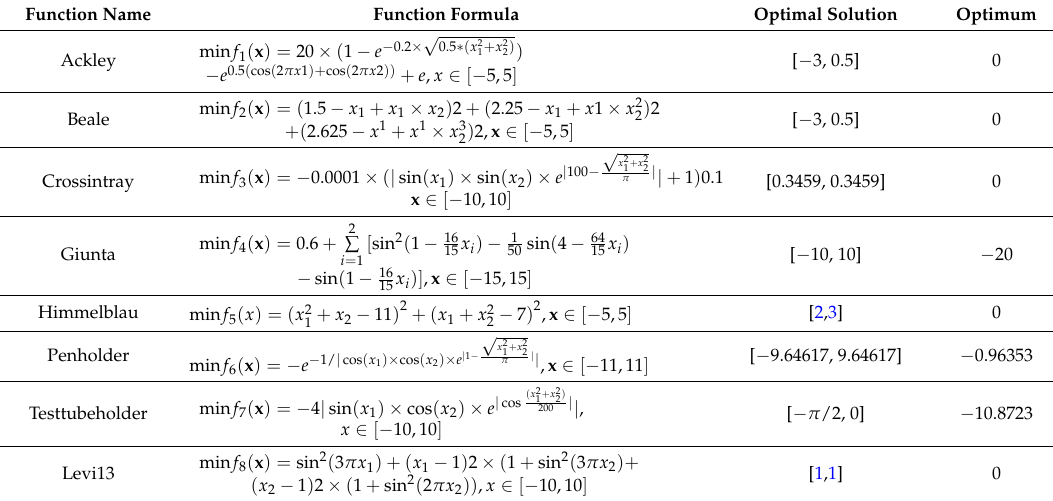
Table 2. Benchmark